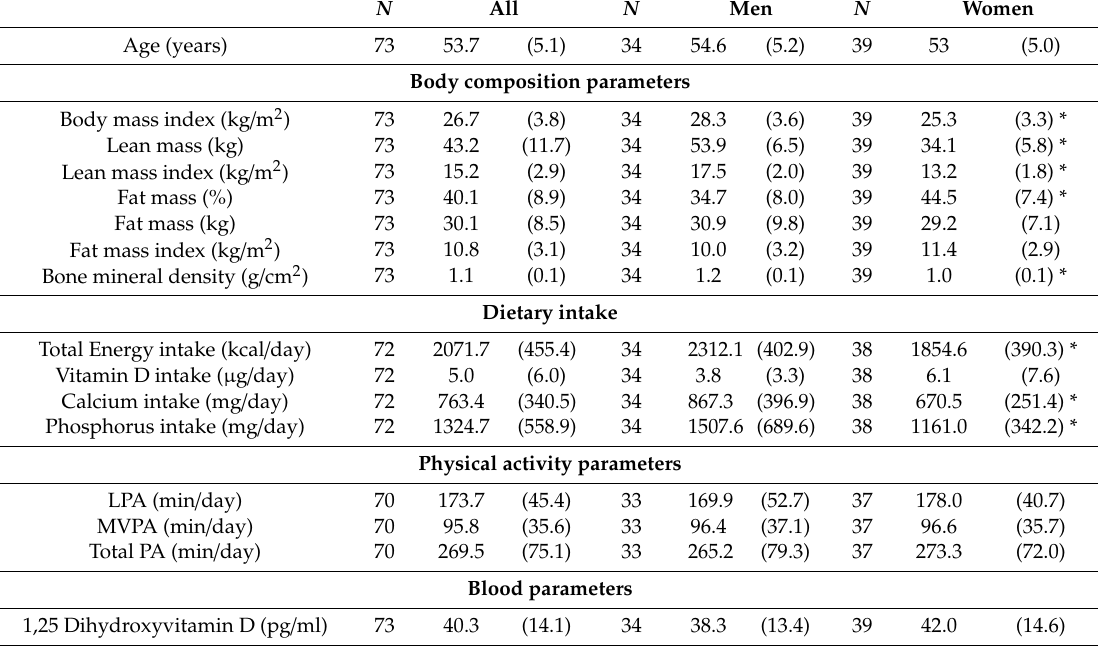
Table 1. Descriptive characteristics of